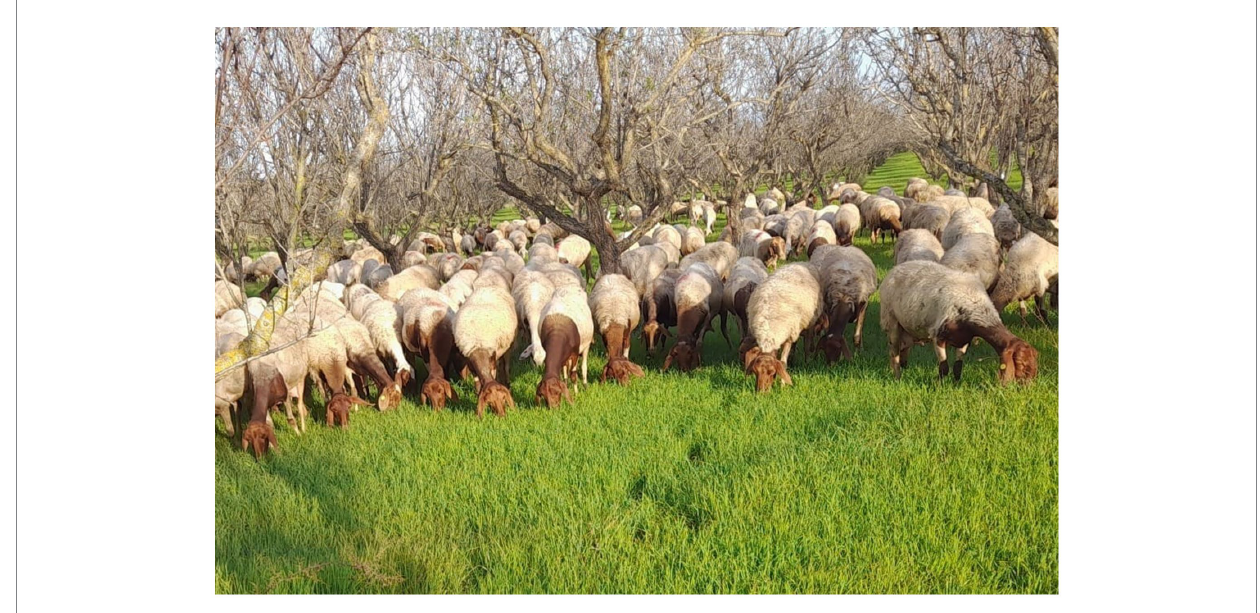
FIGURE 1 Noticiana sheep